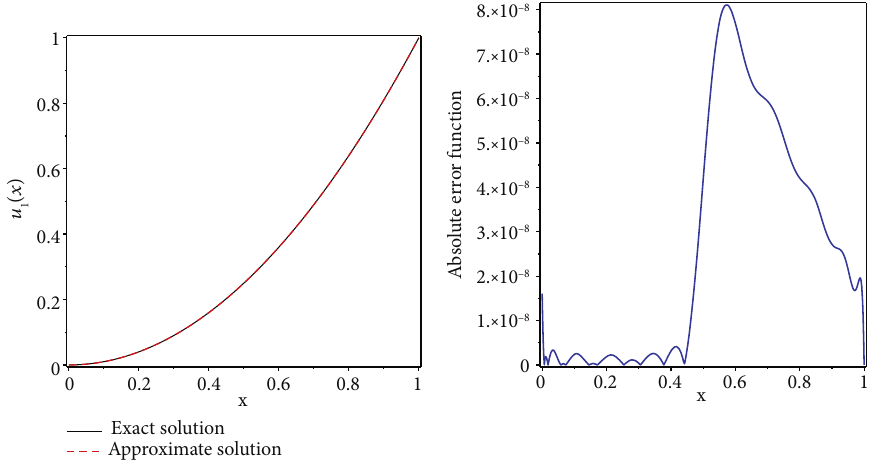
ð x Þ for N = 20 and ν 1